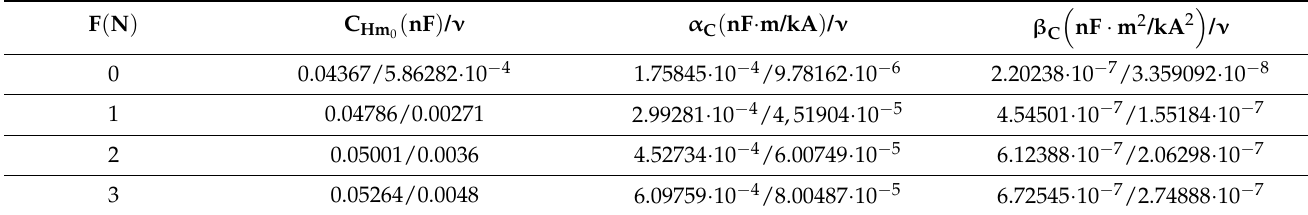
, α C , and β C for F = 0 ÷ 0